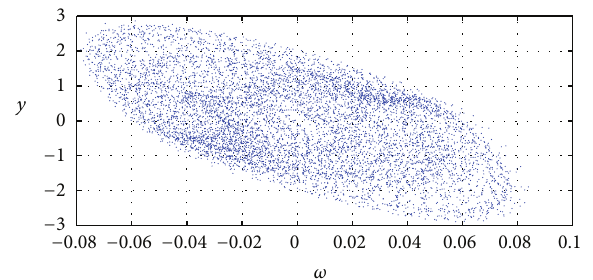
Figure 18: Poincare map with 𝑚 𝑡 = 0